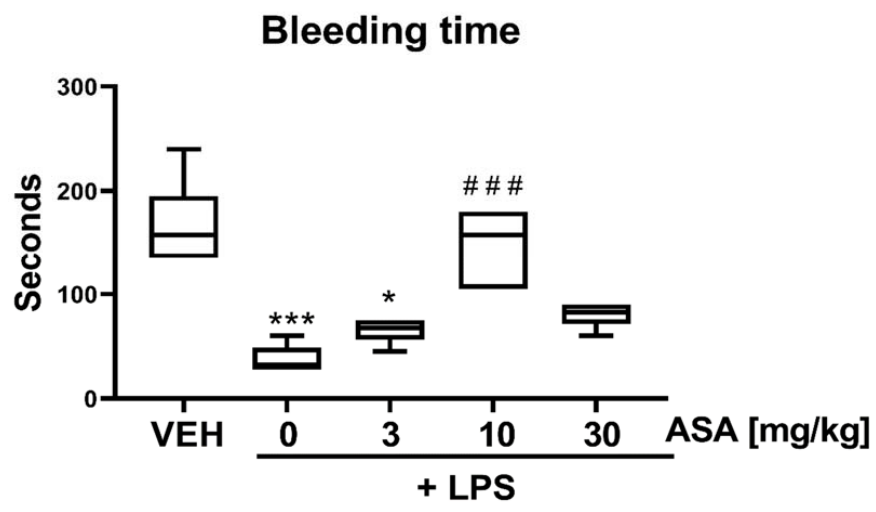
Figure 3. Effect of ASA on BT in LPS ‐ treated mice (* p < 0.05, *** p < 0.001 vs. VEH; ### p < 0.001 vs.